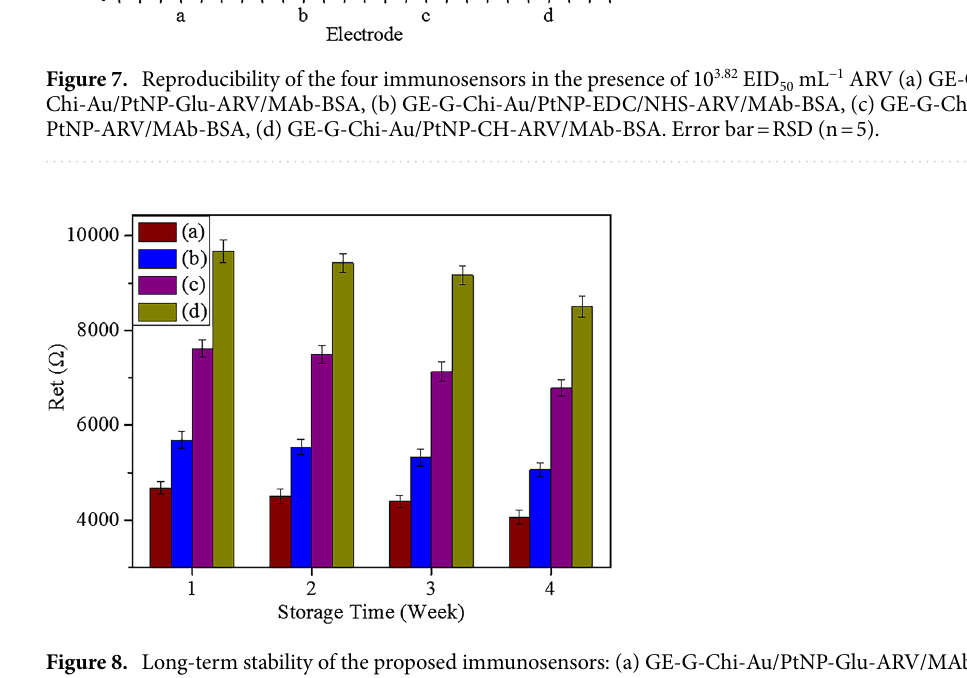
Figure 8. Long-term stability of the proposed immunosensors: (a) GE-G-Chi-Au/PtNP-Glu-ARV/MAb-BSA, (b) GE-G-Chi-Au/PtNP-EDC/NHS-ARV/MAb-BSA, (c) GE-G-Chi-Au/PtNP-ARV/MAb-BSA, (d) GE-G-